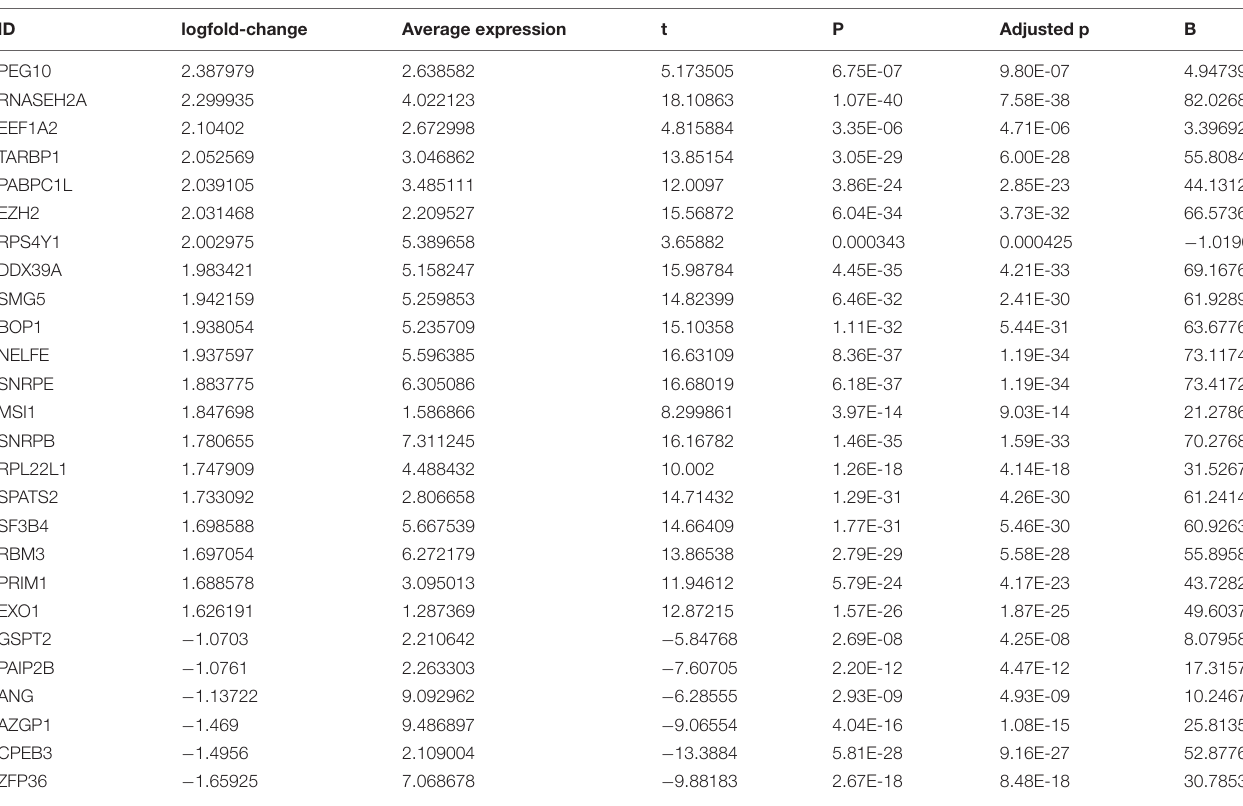
TABLE 2 | The first 20 up-regulated RBPs and 6 down-regulated RBPs in HBV-related